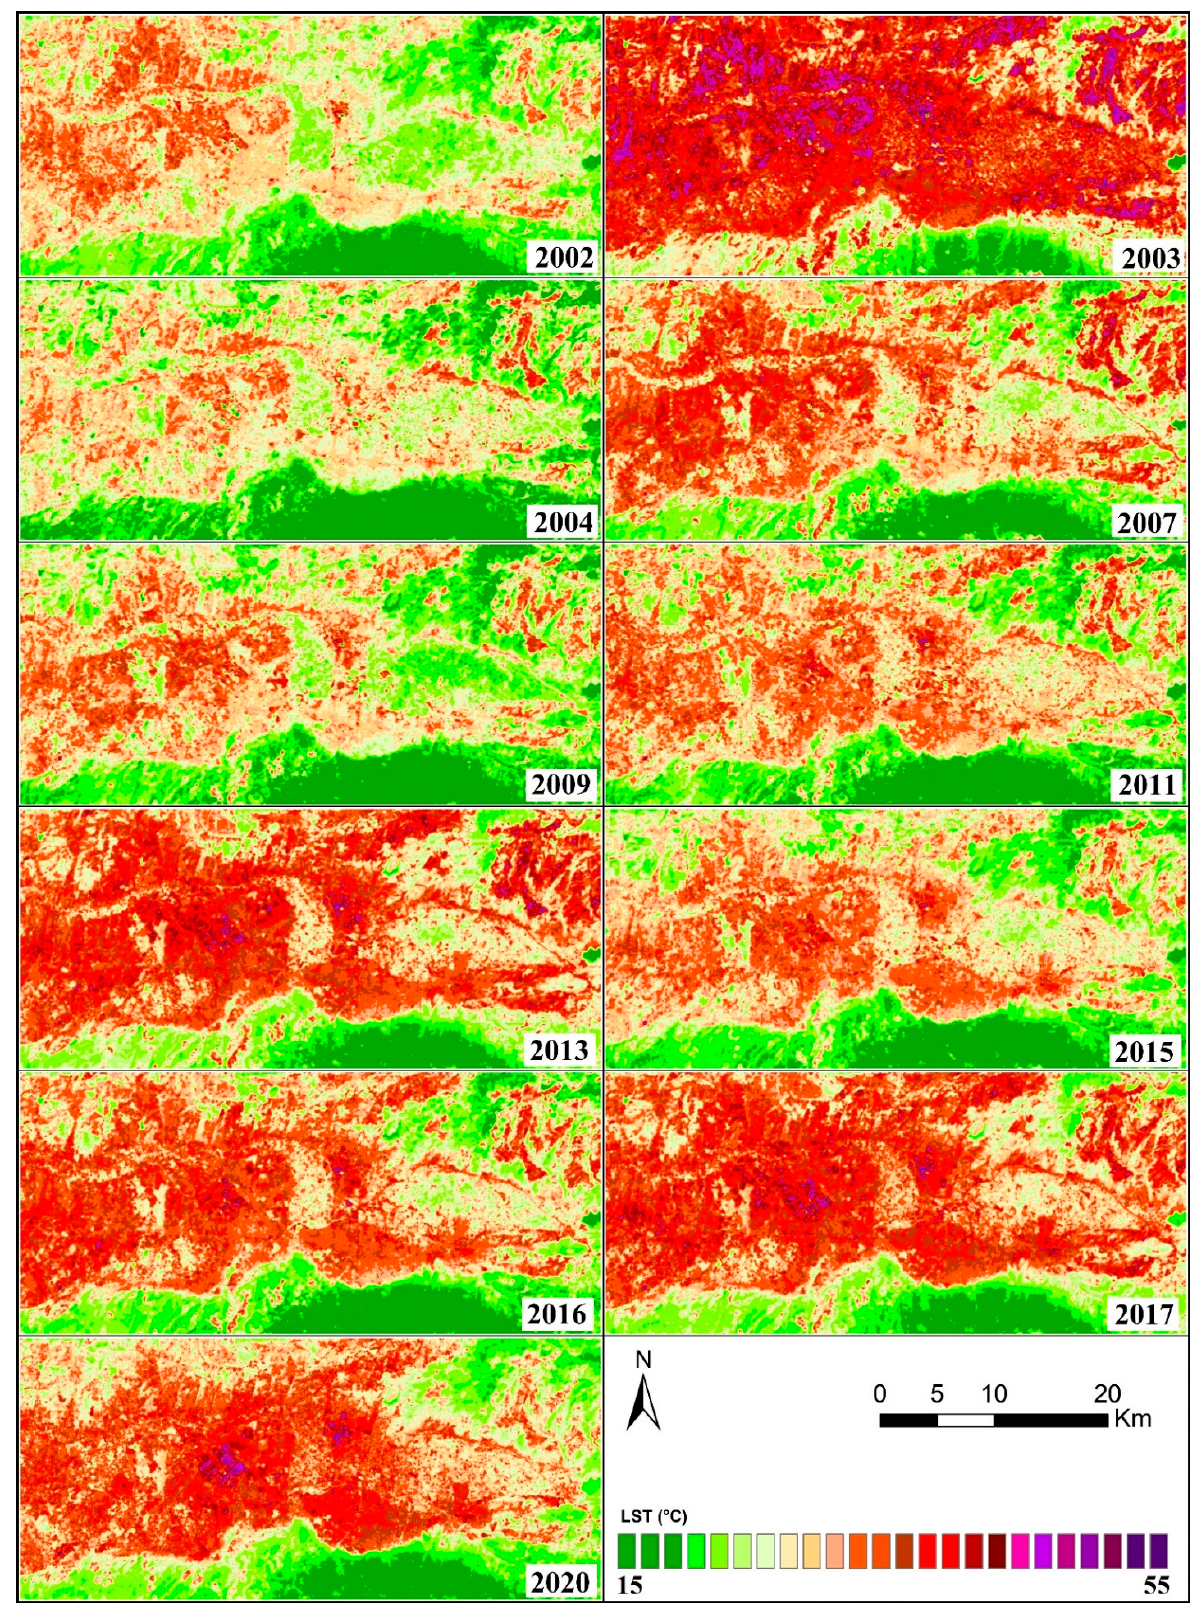
Figure 5. LST imagery of the study area for the years: 2002, 2003, 2004, 2007, 2009, 2011, 2013, 2015, 2016, 2017 and 2020.